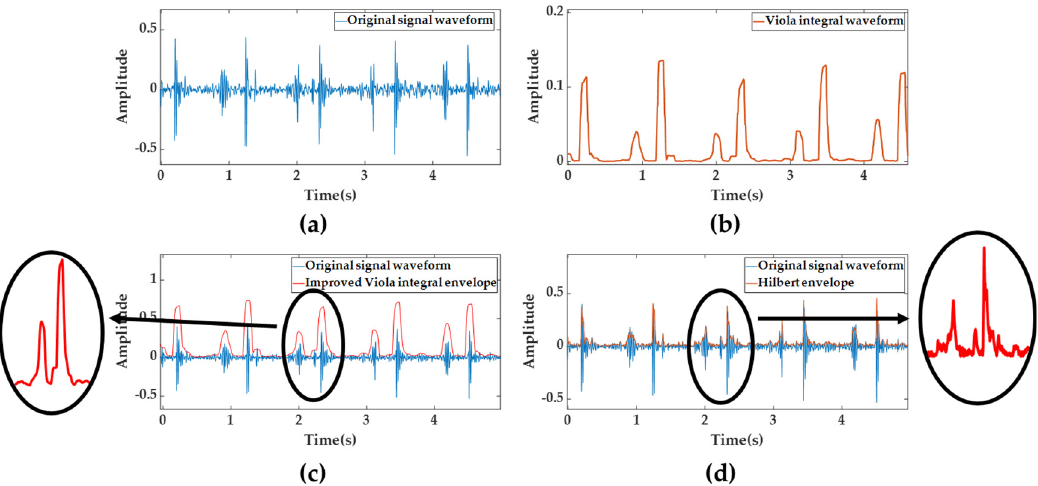
Figure 3. The original signal and the extracted envelope. ( a ) The original PCG signal waveform. ( b ) Viola integral waveform. ( c ) Improved Viola integral envelope. ( d ) Hilbert envelope. ( c , d ) Comparison of two envelope details.